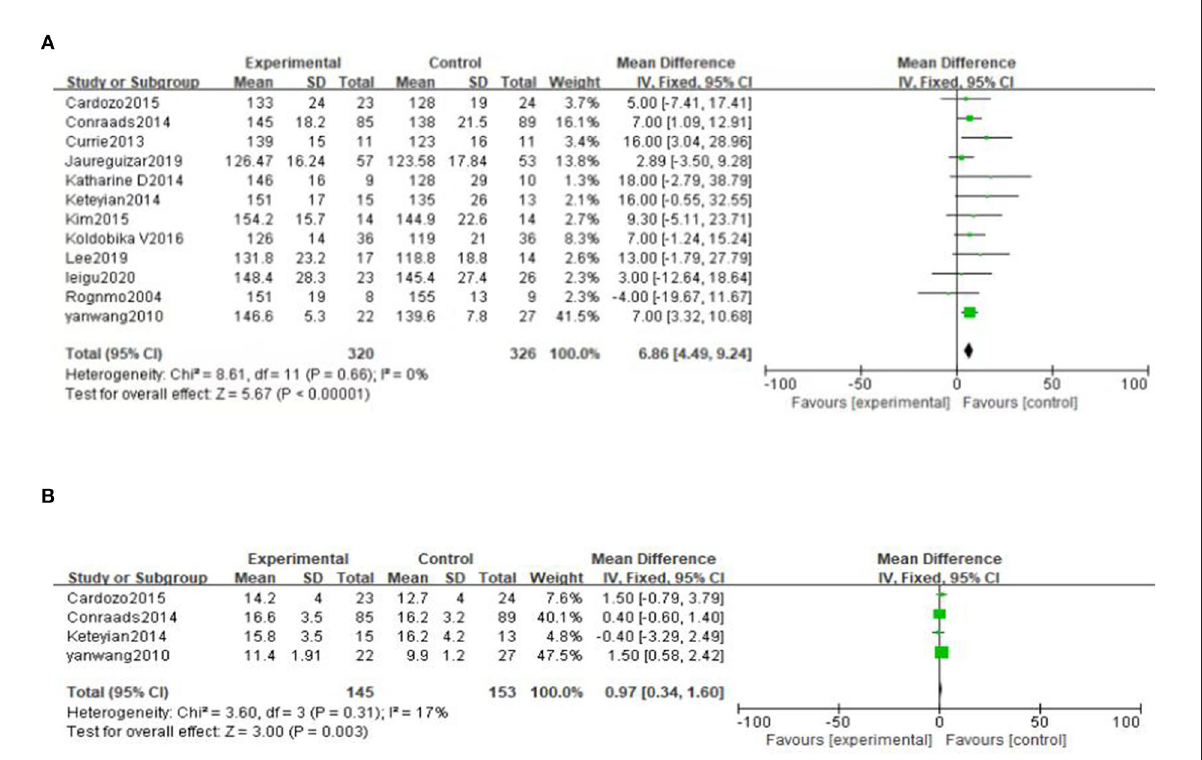
FIGURE9 (A) Forest plot of the effects of high-intensity and moderate-intensity exercise on PHR in CAD patients. (B) Forest plot comparing the improvement effect of two exercise modes on O 2